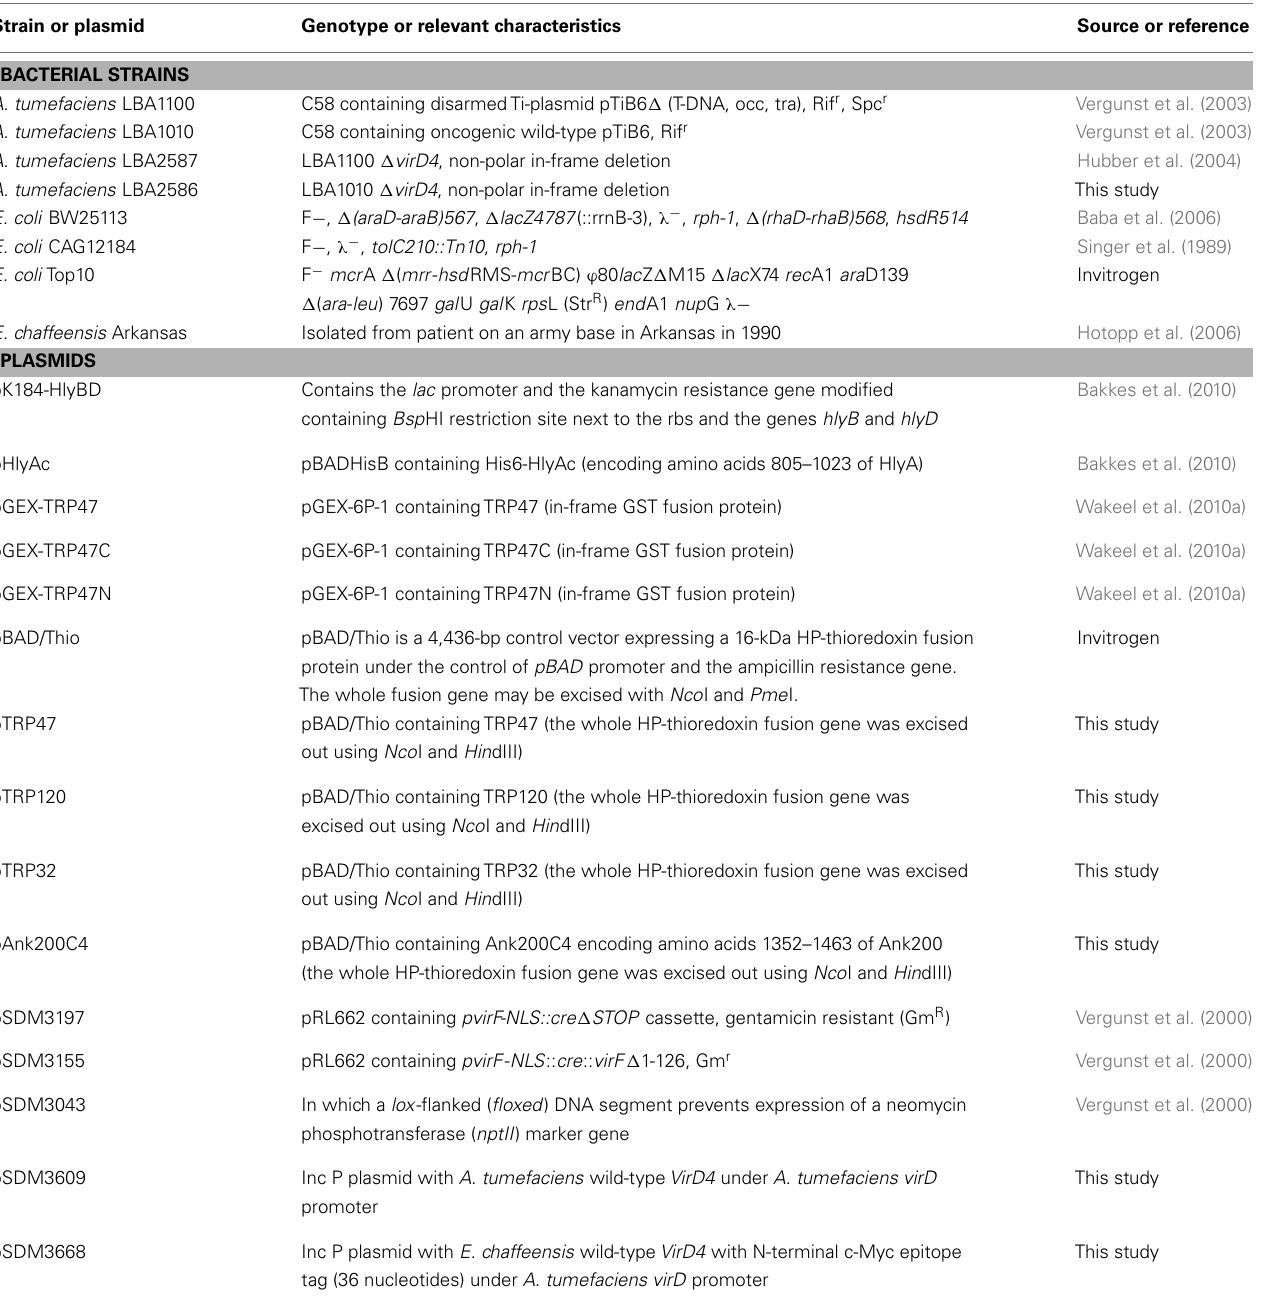
TableA1 |The list of bacterial strains and plasmids used in this study. Strain or